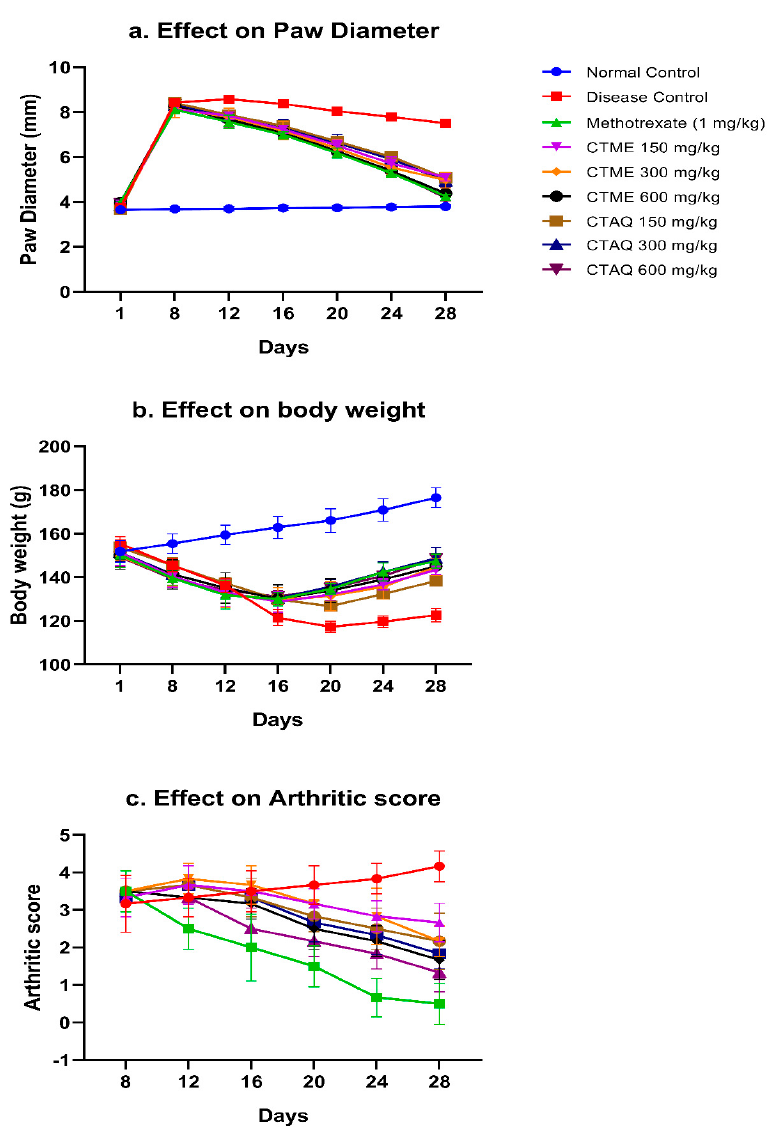
Figure 4. Effect of C. tuberculata on the paw diameter, body weight (g) and arthritic index in arthritic rat values as mean ± S.D ( n = 6). Results were significant p < 0.05–0.0001 as equated to DCG.